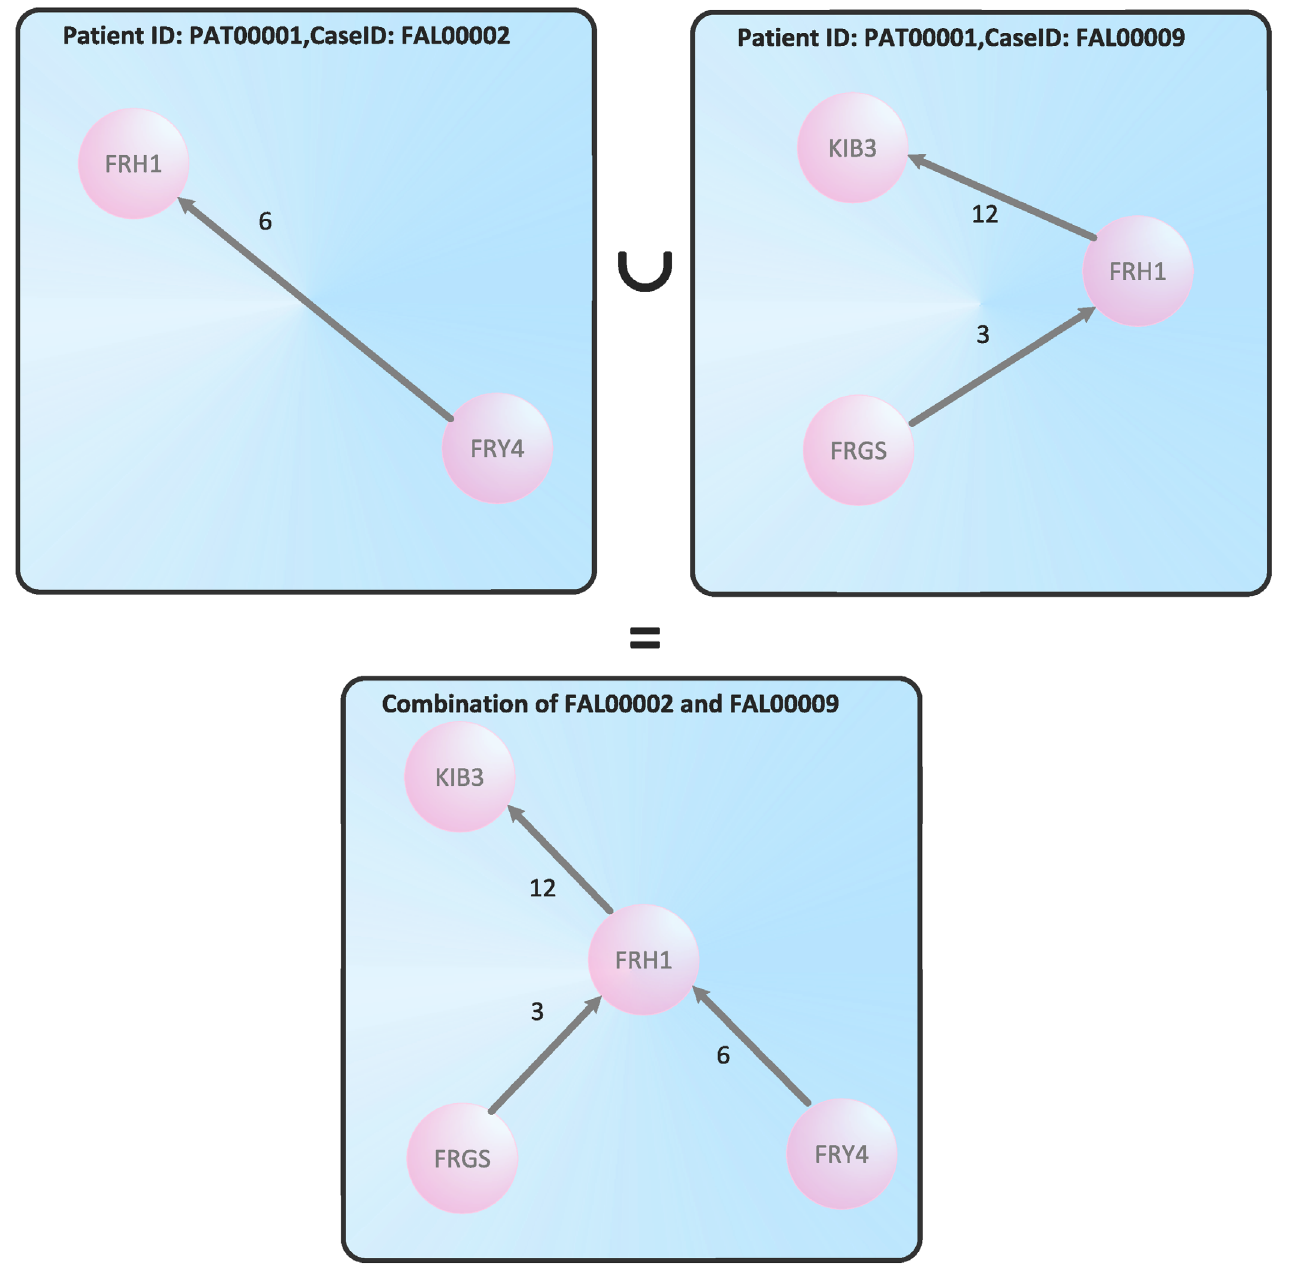
Fig 3. The union of the treatment cycles for the cases FAL00002 and FAL00009.